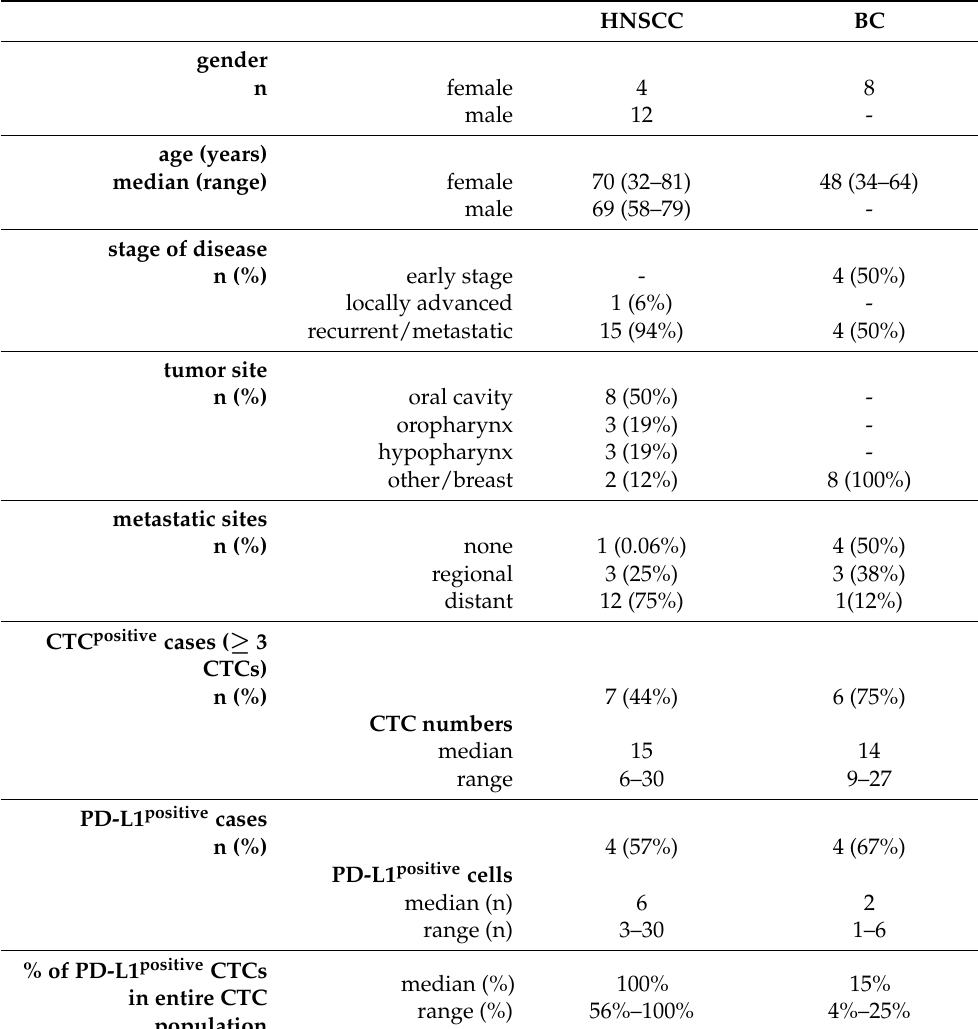
Table 1. Patient